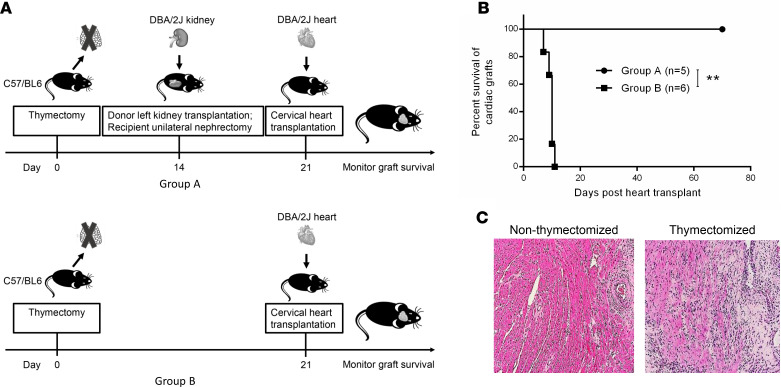
Effect of recipient thymectomy on cardiac graft survival.(A) Schematic representation of experimental design in assessing the influence of recipient thymectomy on cardiac graft survival. Thymectomy was first performed on B6 recipients; 14 days later, 1 group (group A) received DBA/2 kidney transplants, followed by cervical heart transplants 7 days later. The control group (group B) consisted of thymectomized B6 recipients that received heart allografts alone without prior kidney transplant. (B) Survival curves of cardiac grafts in thymectomized recipients in each group of mice described before (group A, n = 5; group B, n = 6). Graft survival curves were constructed by the Kaplan-Meier method. **P < 0.01, log-rank test. (C) Representative images of DBA/2 heart allografts show mild interstitial infiltrates without myocyte necrosis from nonthymectomized (left) and thymectomized recipients (right) (H&E, original magnification, ×400).